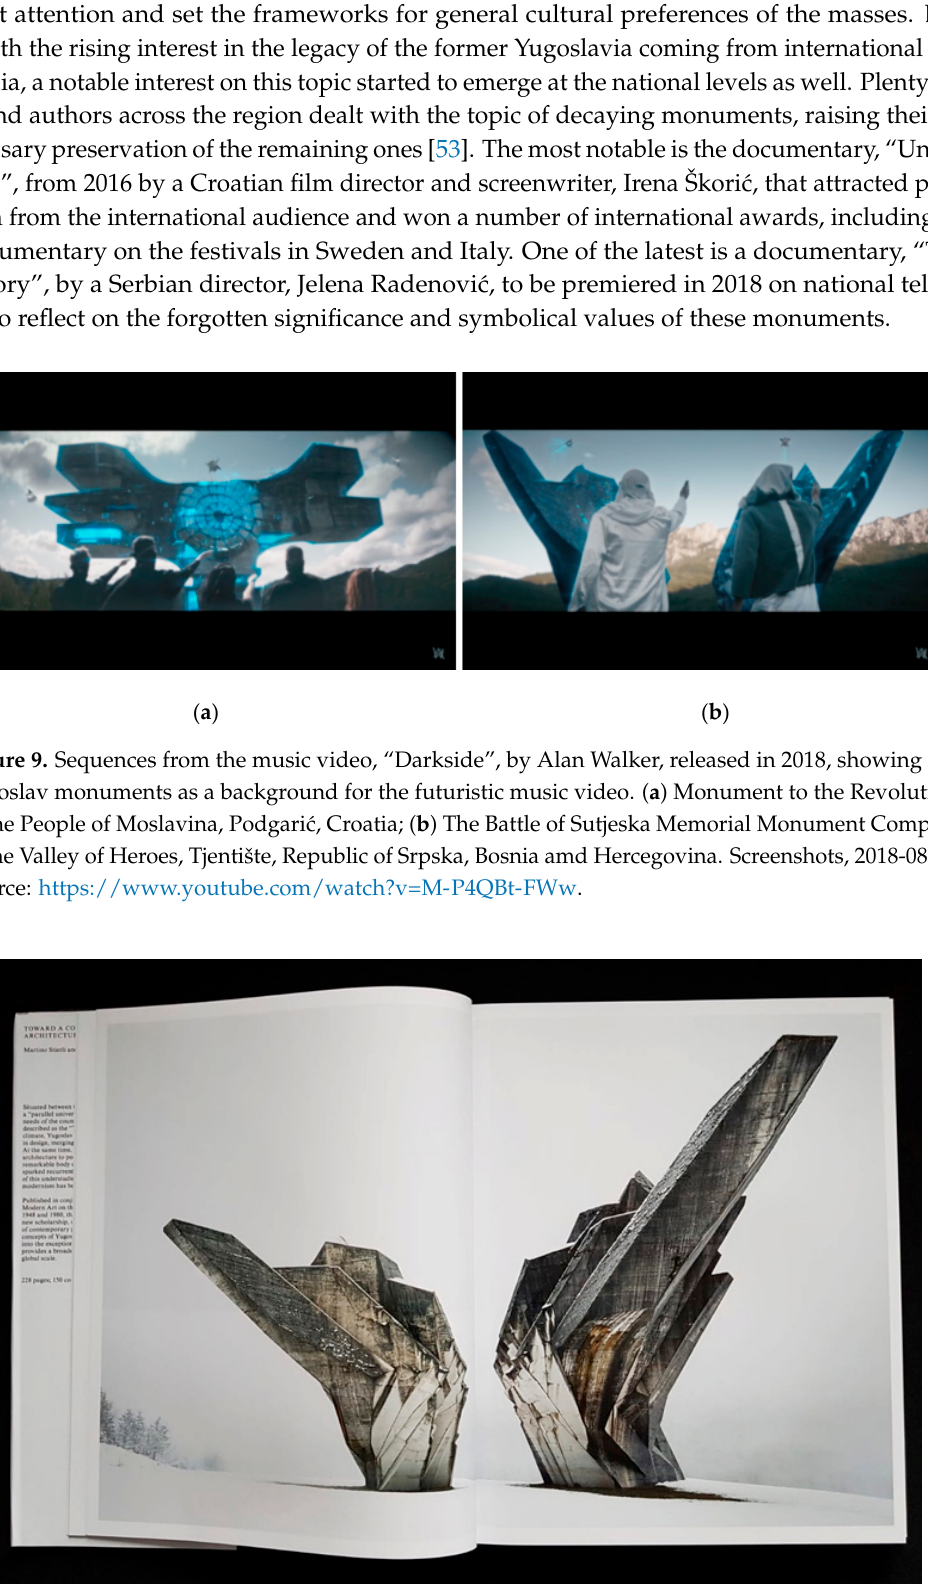
Figure 10. Catalog of the exhibition, “Toward a Concrete Utopia: Architecture in Yugoslavia, 1948– 1980”, at the Museum of Modern Art (MoMA) in New York, showing the Battle of Sutjeska Memorial Monument Complex in Tjentište, Bosnia Herzegovina. Source: Author’s